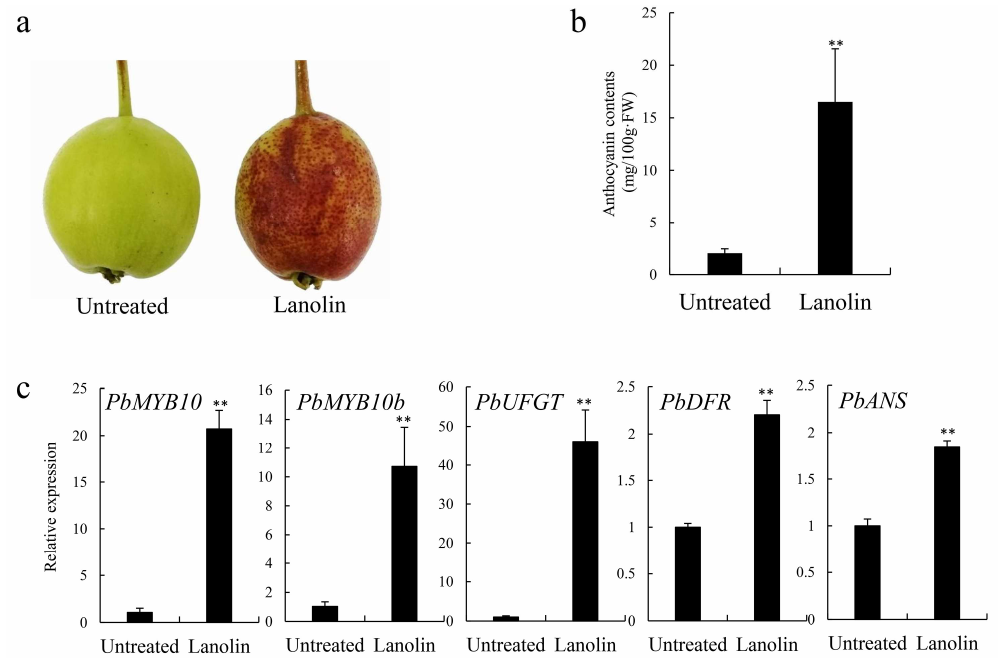
Figure 1. Anthocyanin biosynthesis was induced by a lanolin treatment in ‘Zaosu’ pear fruit at 10 d after treatment. ( a ) For untreated control and lanolin-treated ‘Zaosu’ fruit phenotypes of peels at 10 days after treatment; ( b ) total anthocyanin contents; and ( c ) expression levels of anthocyanin biosynthetic structural and regulatory genes were determined. ** indicates significant differences at p < 0.01. All the data are means ± SDs of three biological replicates.